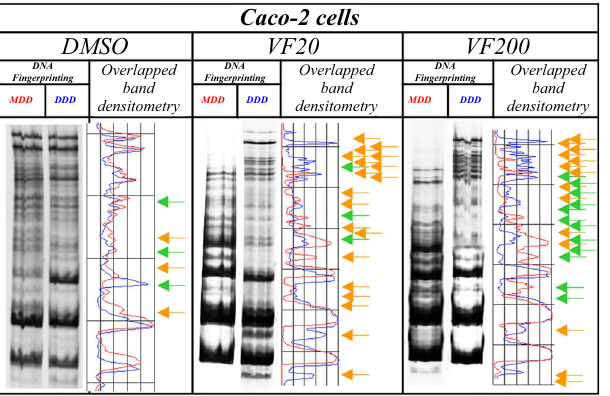
Figure 5. Representative MeSAP-DNA fingerprinting, and relative scanning densitometry, indicating genomic DNA methylation of Caco-2 cells treated with: (from left) DMSO – vehicle; 20 µM (±)- trans -δ-viniferin (VF20); 200 µM (±)- trans -δ-viniferin (VF200). Band pattern variation, in terms of intensification/weakening (green arrows) and appearance/disappearance (orange arrows) of bands was evaluated by densitometer scanning of mono-digested DNA (MDD, profile in red) in comparison with double-digested DNA (DDD, profile in blue). The number of total variations was reported in Table 1. Original blots/gels are presented in Supplementary Fig. 1.